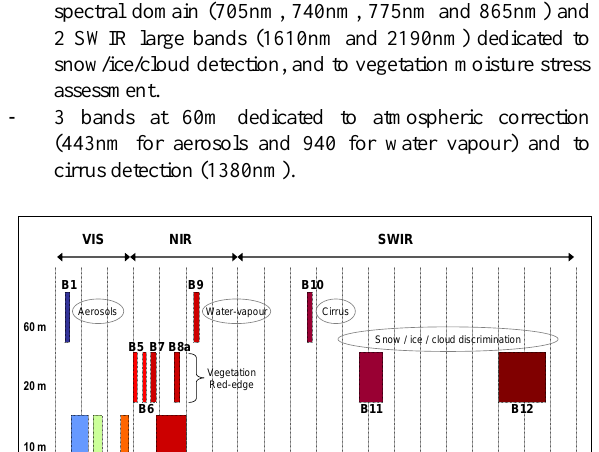
6 bands at 20m: 4 narrow bands in the vegetation red edge spectral domain (705nm, 740nm, 775nm and 865nm) and 2 SWIR large bands (1610nm and 2190nm) dedicated to snow/ice/cloud detection, and to vegetation moisture stress